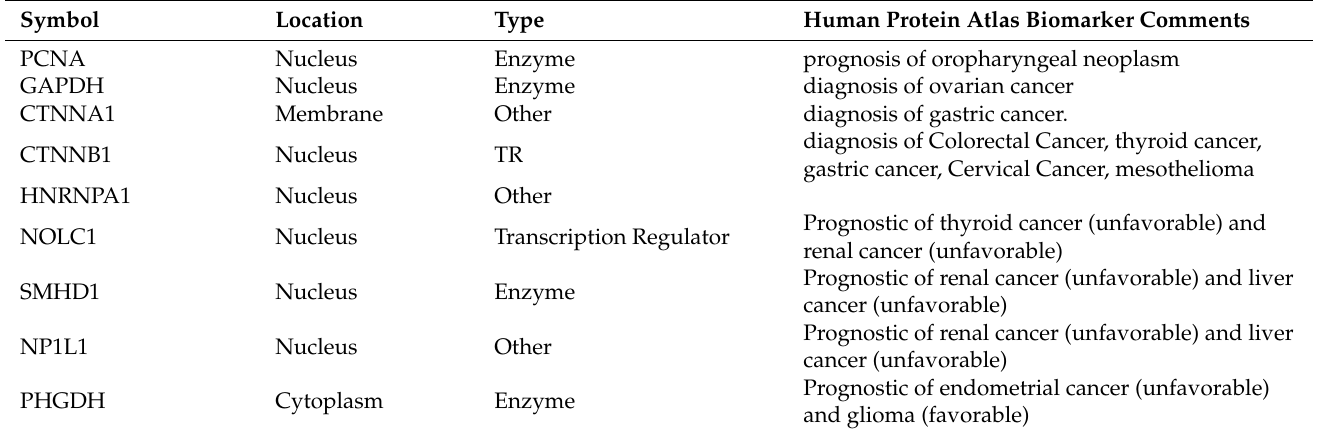
Table 1. Key protein found in this